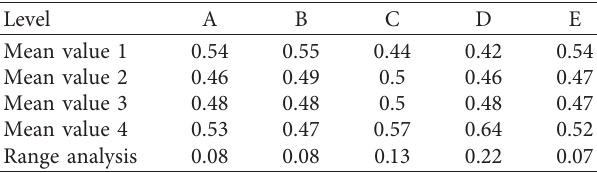
Table 10: Gray correlation range